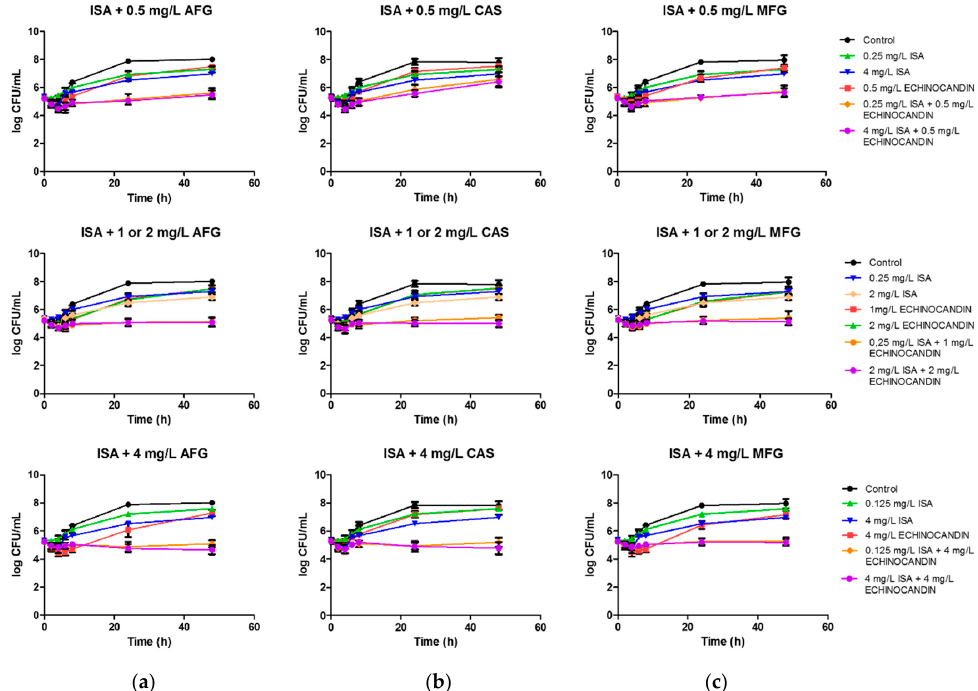
Figure 4. Mean time-kill curves for isavuconazole (ISA) in combination with echinocandins against C. auris. Each data point represents the mean result ± standard deviation (error bars) of the six isolates and replicates. ( a ) Mean time-kill curves for isavuconazole (ISA) in combination with anidulafungin (AFG). ( b ) Mean time-kill curves for isavuconazole (ISA) in combination with caspofungin (CAS). ( c ) Mean time-kill curves for isavuconazole (ISA) in combination with micafungin (MFG).